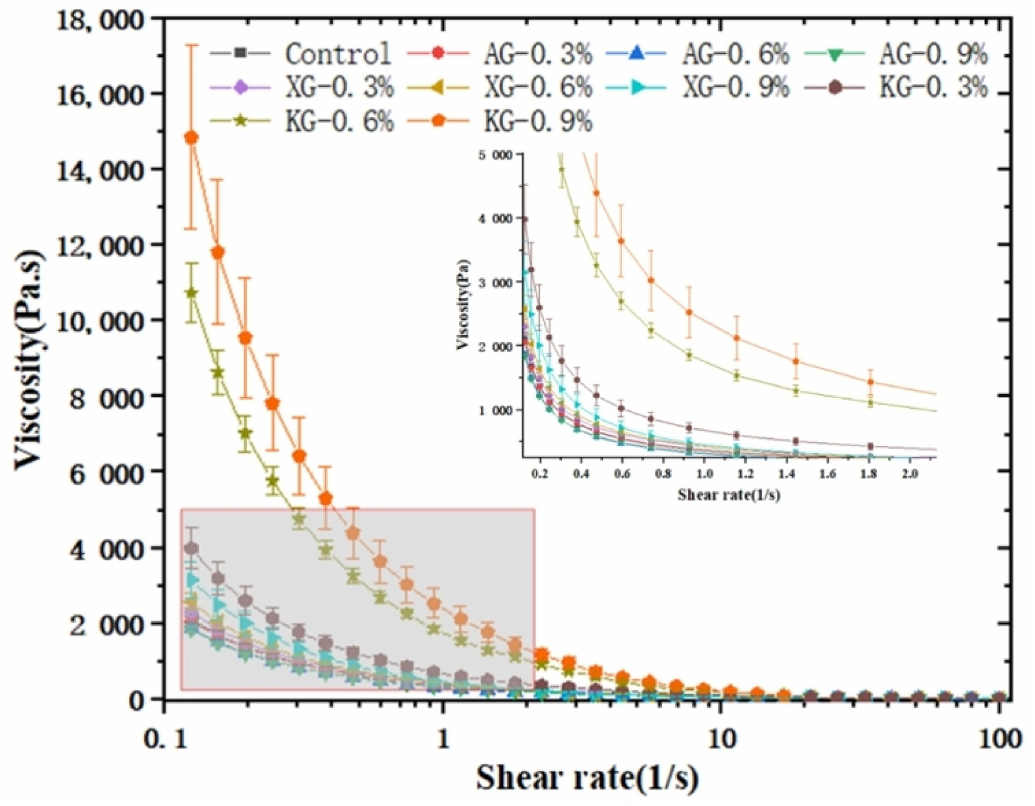
Figure 2. Apparent viscosity profiles for different ink samples. Consistency index K , closely correlated with extrusion performance of food